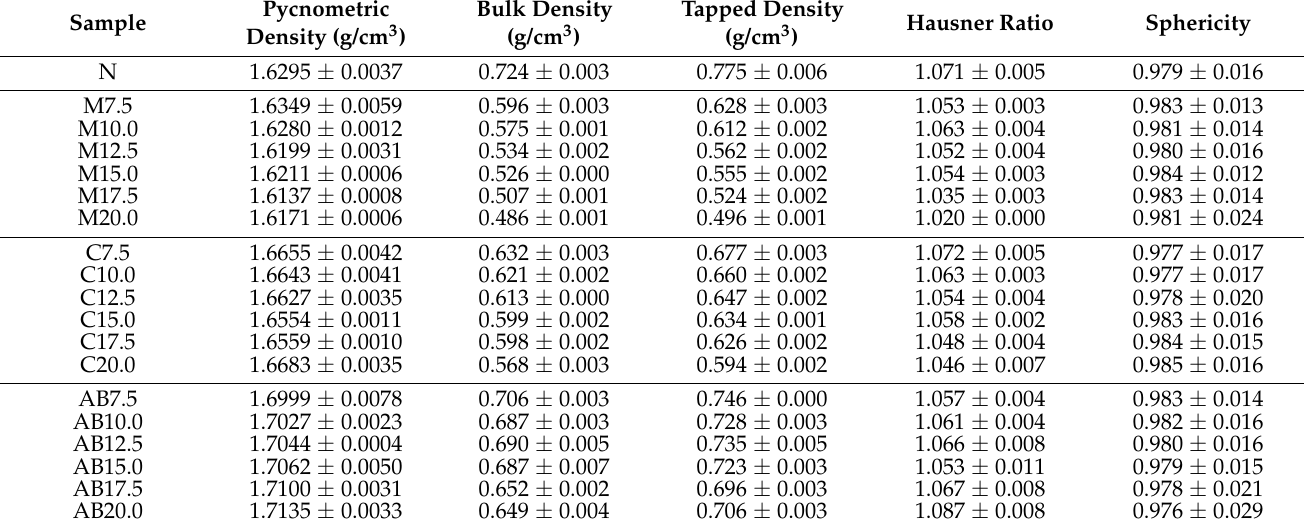
Table 2. Selected physicochemical properties of